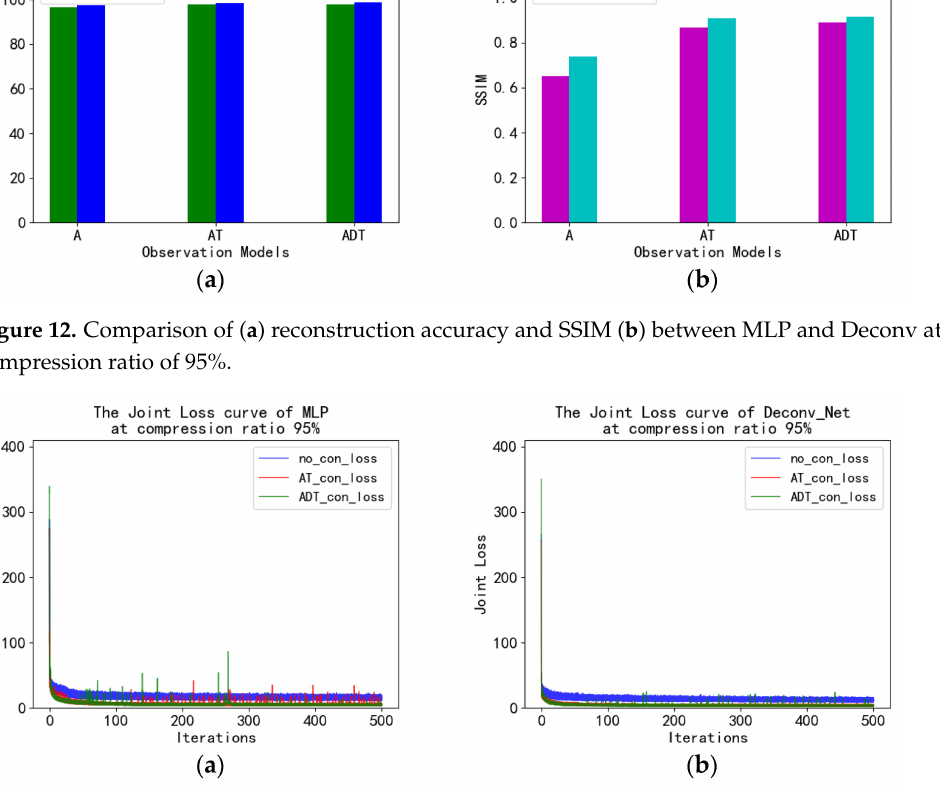
Figure 13. The joint loss curve with the end-to-end MLP model ( a ) and the end-to-end Deconv_Net model ( b ) at a 95% compression ratio.